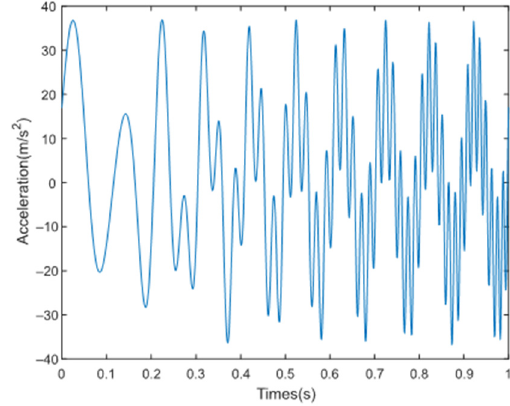
Figure 4. The signal without noise.